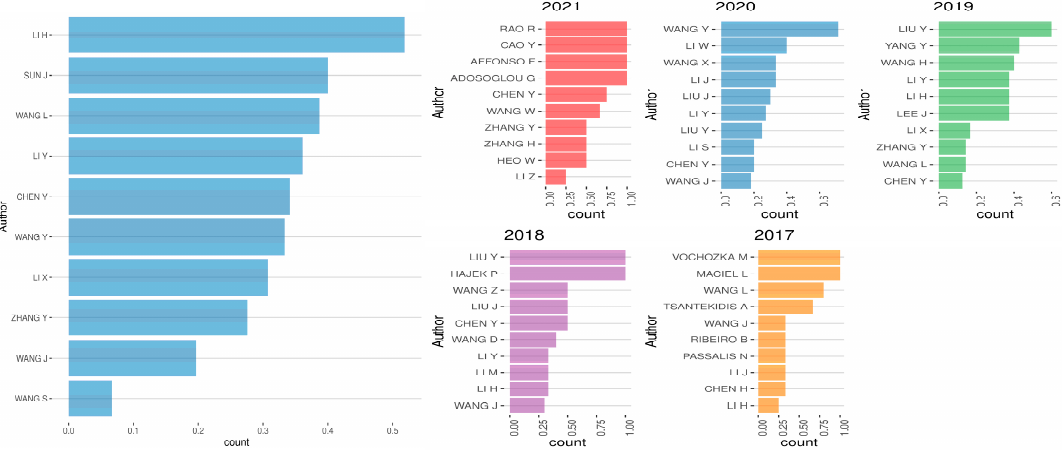
Figure 7. Author dominance ranking, overall period, and per year.